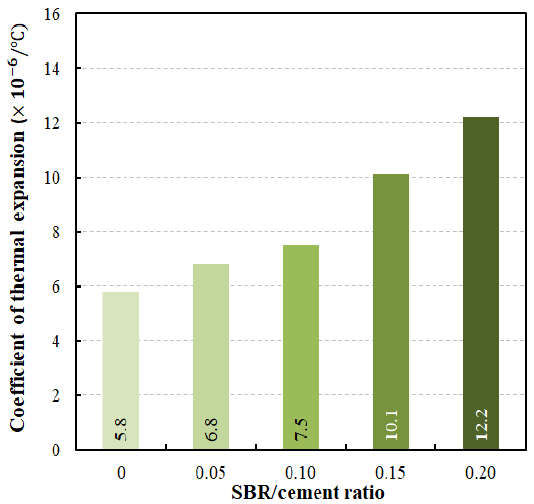
ffi cients of thermal expansion for di ff erent SBR / cement Figure 11. Coefficients of thermal expansion for different SBR/cement ratios. Figure 11. Coe